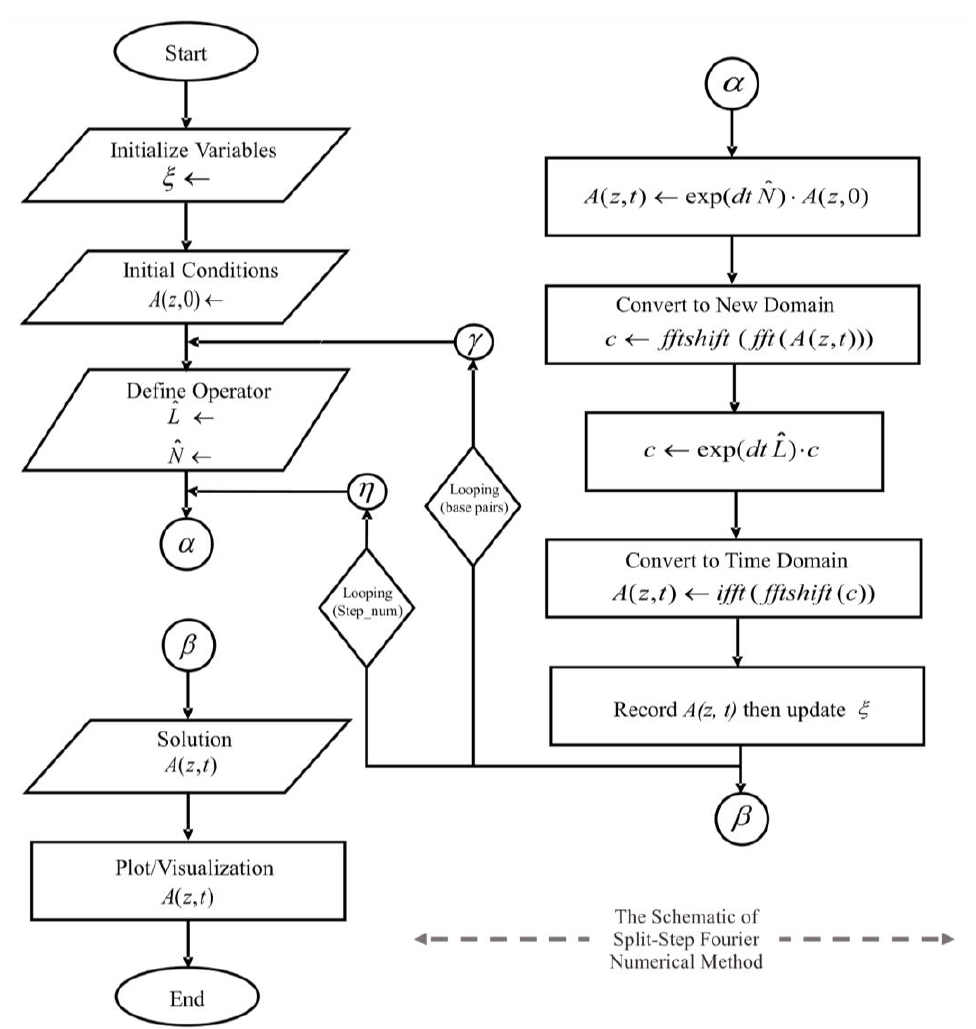
Figure 3. Flowchart of the numerical method to obtain a soliton-like solution from NLS-like